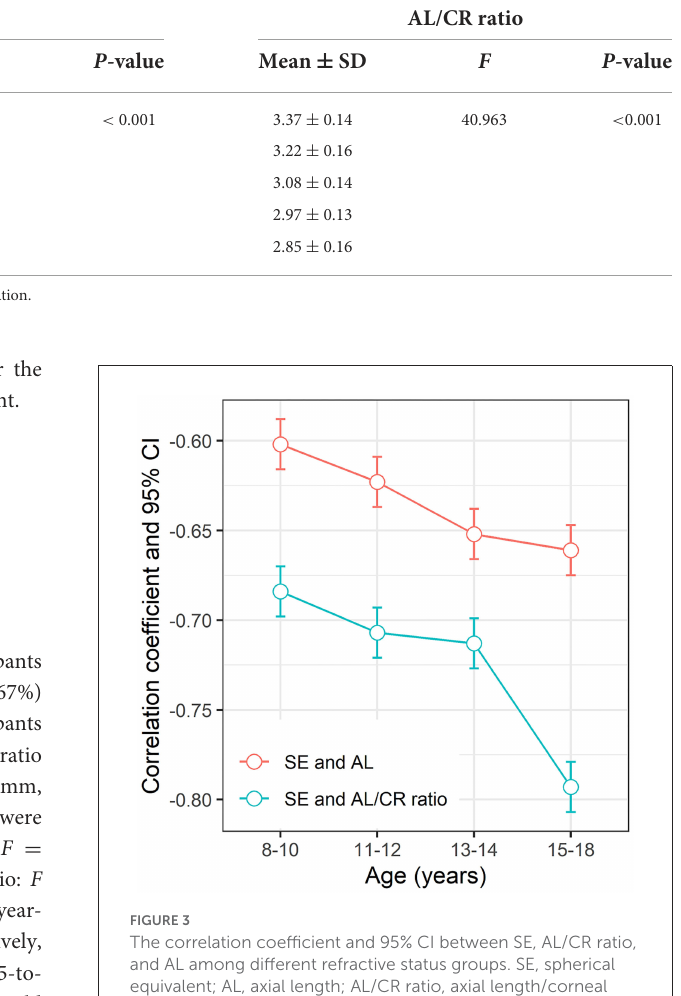
The Pearson correlation coefficient between age and AL was 0.218 ( P < 0.05), 0.394 ( P < 0.05) between age and AL/CR